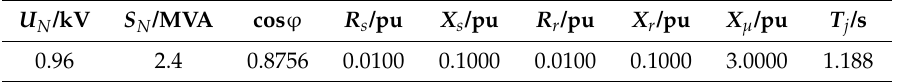
Table A1. Wind Generator Parameters.